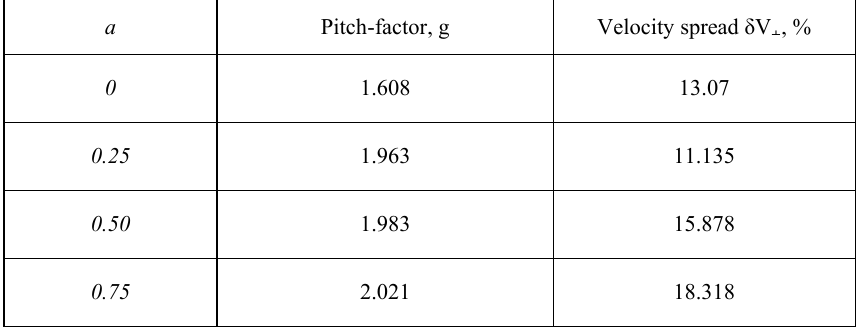
Table 1. HEB parameters calculated for different heterogeneity of thermionic